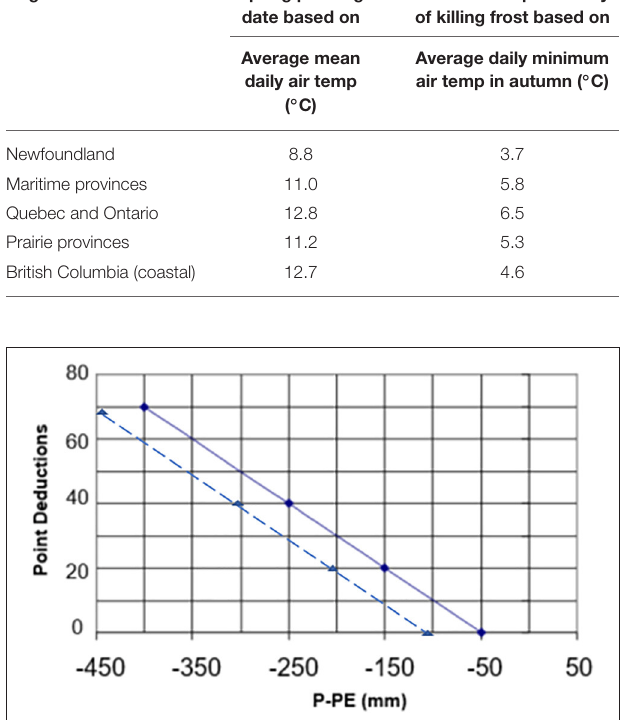
TABLE 5 | Definition of start and finish of the growing season for corn in eastern Canada. Region